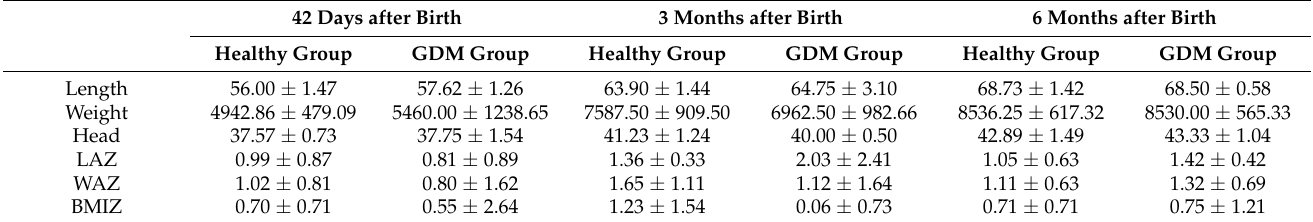
Table 3. E ff ects of di ff erent levels of HMOs on infant growth and development in Se + Le + group.